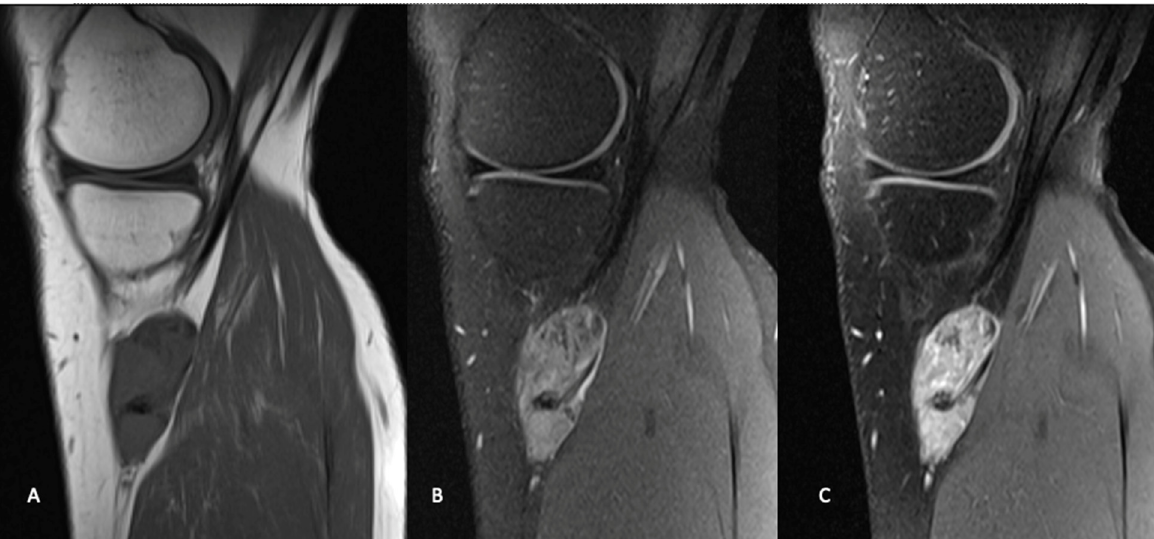
Figure 2. Sagittal MR images in the same patient demonstrate a periarticular soft tissue mass situated posteromedial to the proximal tibia, in close relation to the pes anserine tendons. The mass demonstrates intermediate signal on T1 weighted images ( A ), and heterogeneously high signal on T2 weighted fat-saturated images ( B ). T1 weighted fat-saturated after gadolinium administration ( C ), demonstrates heterogeneously avid enhancement. Known areas of calcification are low signal on all sequences (arrow).